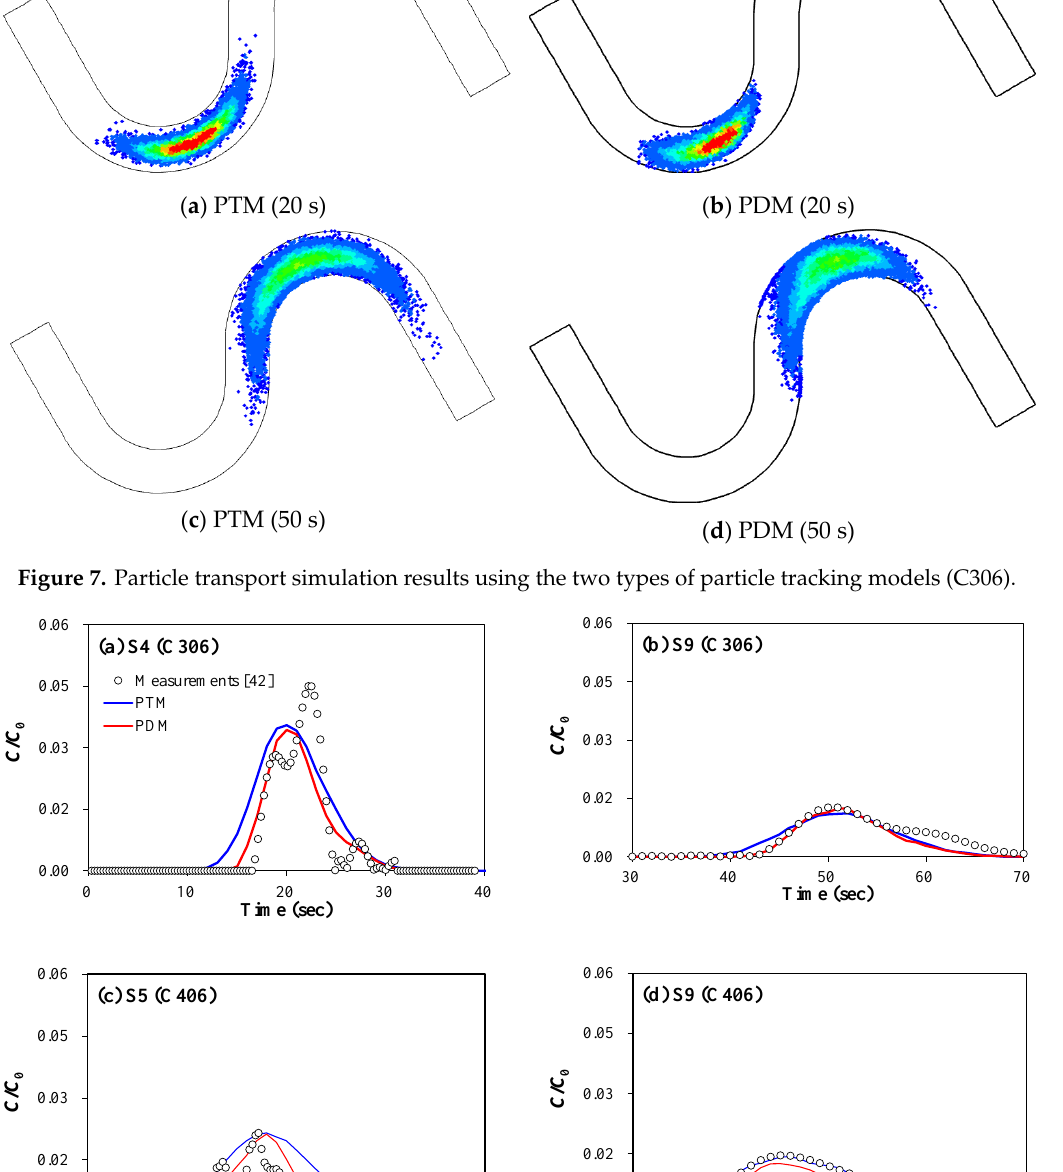
Figure 8. Temporal variations of concentration curves at y / W = 0.45 within the channel bends.